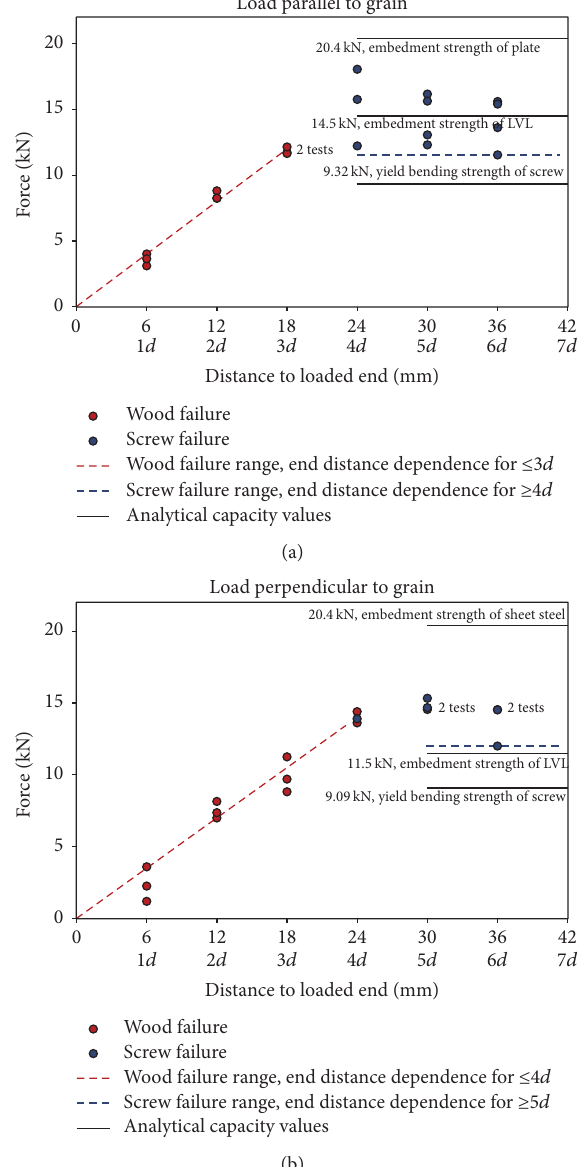
Figure 12: Results of end distance tests for loading (a) parallel and (b) perpendicular to grain of the LVL core. Three tests were performedforeachconfigurationexceptforthetestsparalleltograin with end distances 5𝑑 and 6𝑑 , where four tests were